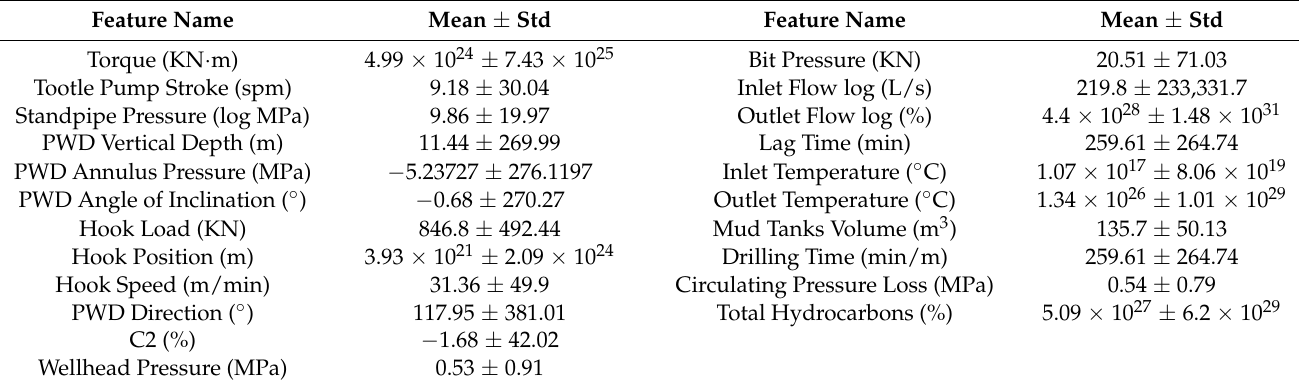
Table 1. Selected features with mean and standard deviation.